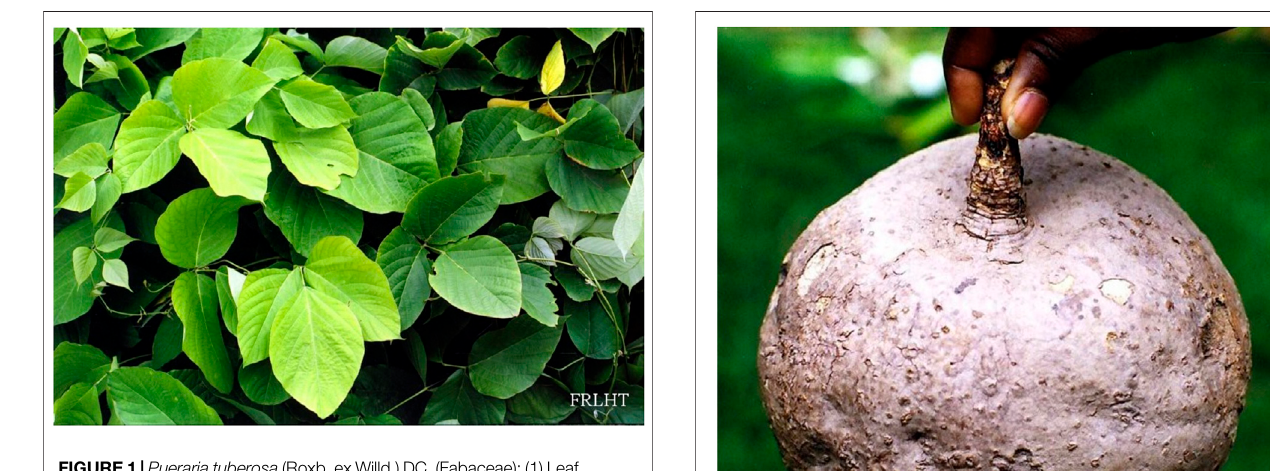
FIGURE1| Pueraria tuberosa (Roxb.exWilld.)DC. (Fabaceae):(1) Leaf. (2 – 4) Tuber.